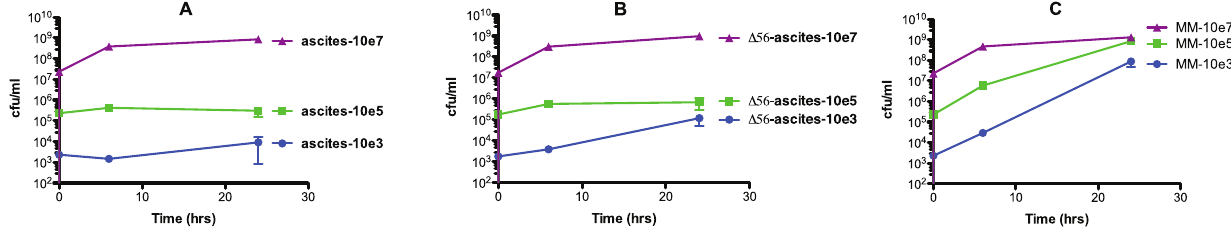
Figure 1. Growth and/or survival of hvKP1 (wt) in 100% human ascites and M9 minimal medium. The growth and/or survival of hvKP1 was assessed at 0, 3, 6, and 24 hours in 100% human ascites (batch 2) or M9 minimal medium at the starting inocula of approximately 10 3 cfu/ml, 10 5 cfu/ml, and 10 7 cfu/ml. Panel A: 100% human ascites, Panel B: 100% human ascites heated at 56 u C for 30 minutes, and Panel C: M9 minimal medium. Data are Mean 6 S.E.M.; N=3.